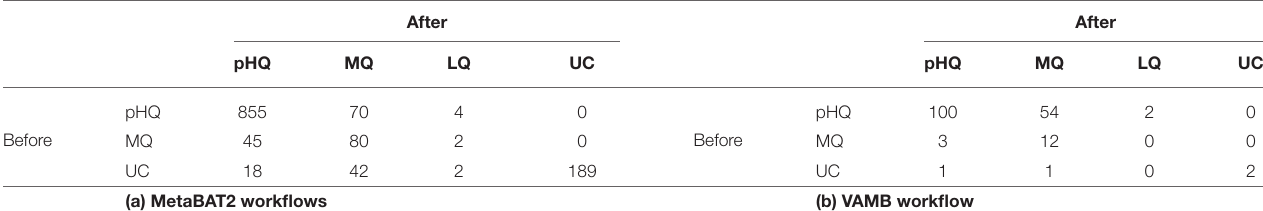
TABLE 2 | Number of MAGs categorized by genome quality assignments before and after decontamination with RefineM for (A) MAGs obtained from MetaBAT2 workflows and (B) MAGs from VAMB